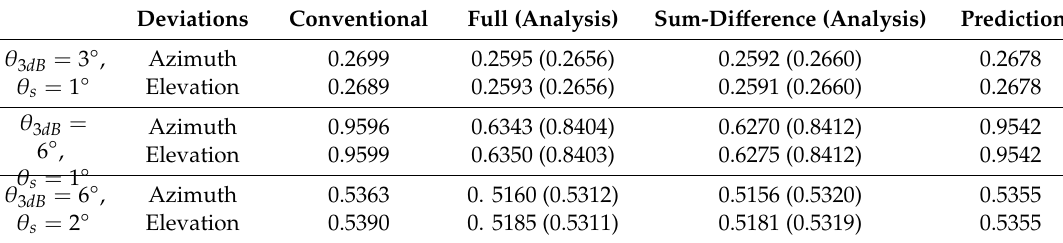
Table 3. RMS errors for beam width and squint angle: θ az = 0 ◦ , θ el = 0 ◦ , σ = 0.1 ◦